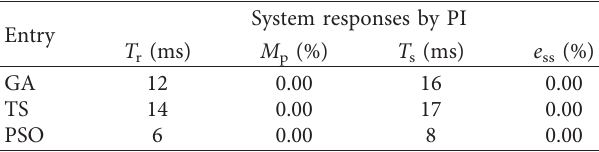
Figure 24: Result of maintaining voltage stability and current while changing load using a PI controller with PSO search. Table 3: System response by the PI controller at